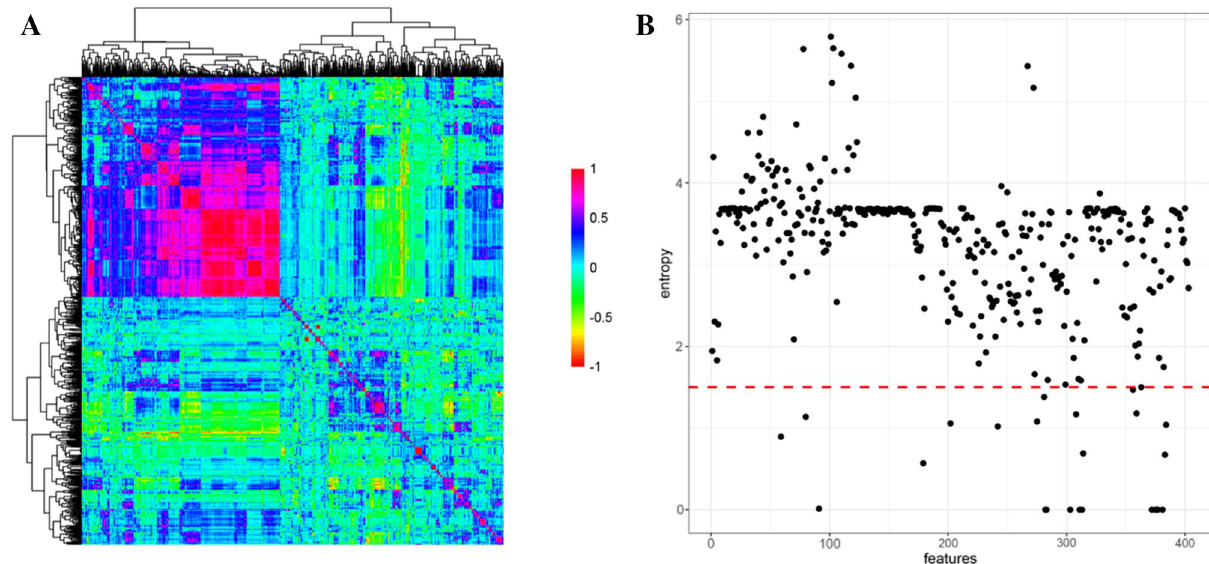
Figure 3. The feature selection process. ( A ) The correlation matrix of 1444 features achieved from PaDEL has been displayed. The values range from − 1 to 1, with − 1 denoting a negative correlation and 1 denoting a positive correlation. Features that were highly correlated (cutoff = 0.9) were removed. ( B ) Features with low entropy (below the red dashed line) were